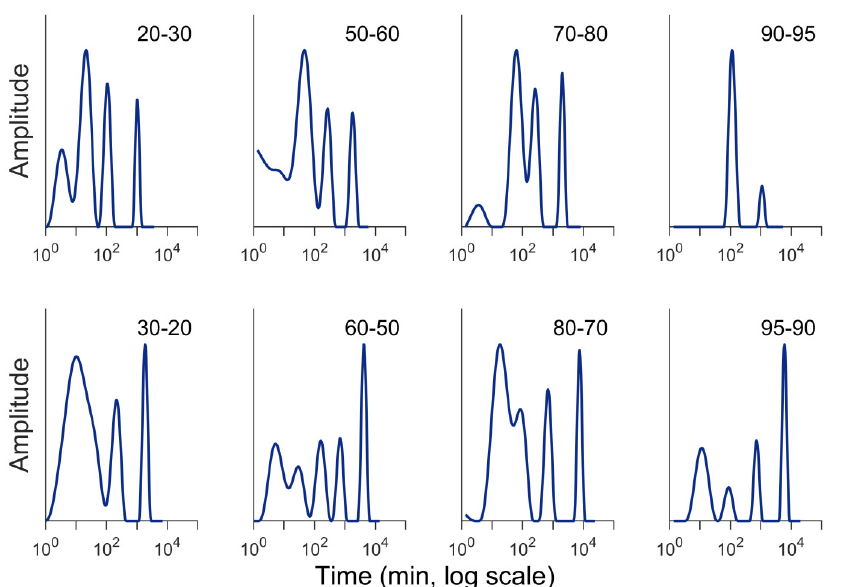
Figure 9. Spectra of characteristic time constants found by multi-exponential decay analysis (MEDEA) on absorption and desorption data until equilibrium for loblolly pine ( Pinus taeda L.) using an automated sorption balance [139]. The numbers above each spectrum indicates the RH step, e.g., “20–30” denotes the step from 20% RH to 30% RH.